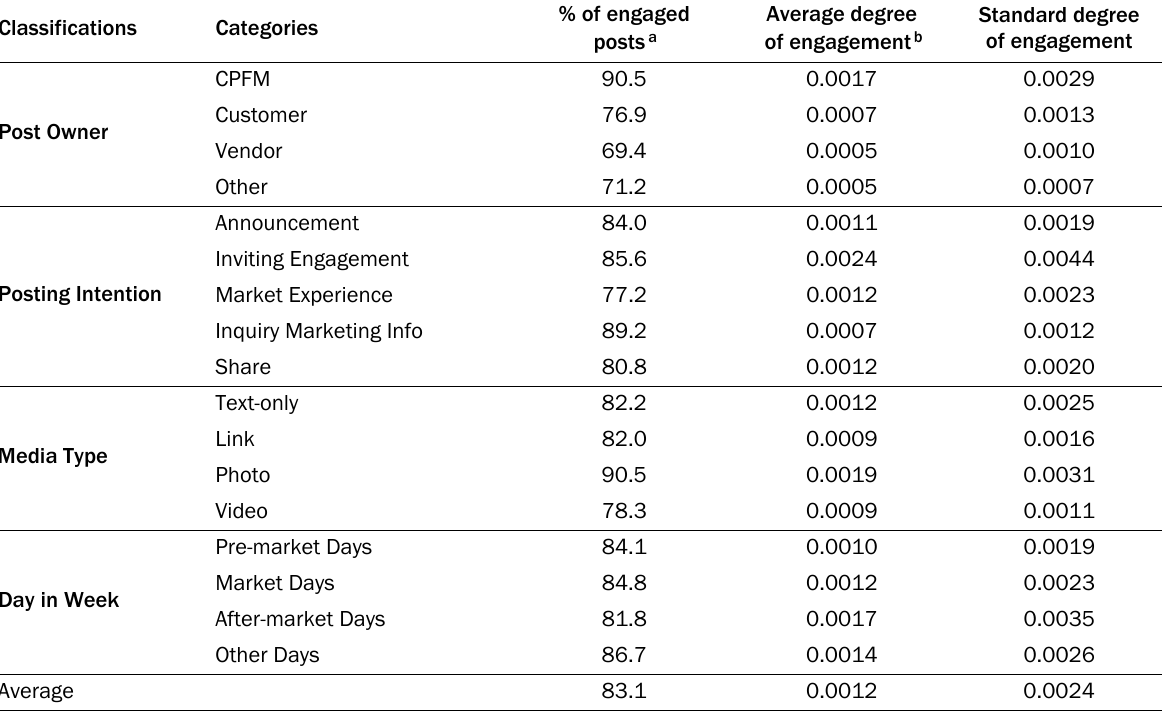
Table 3. Distribution of Engaged Posts ( N =6,369 and Degree of Engagement by Post Classifications